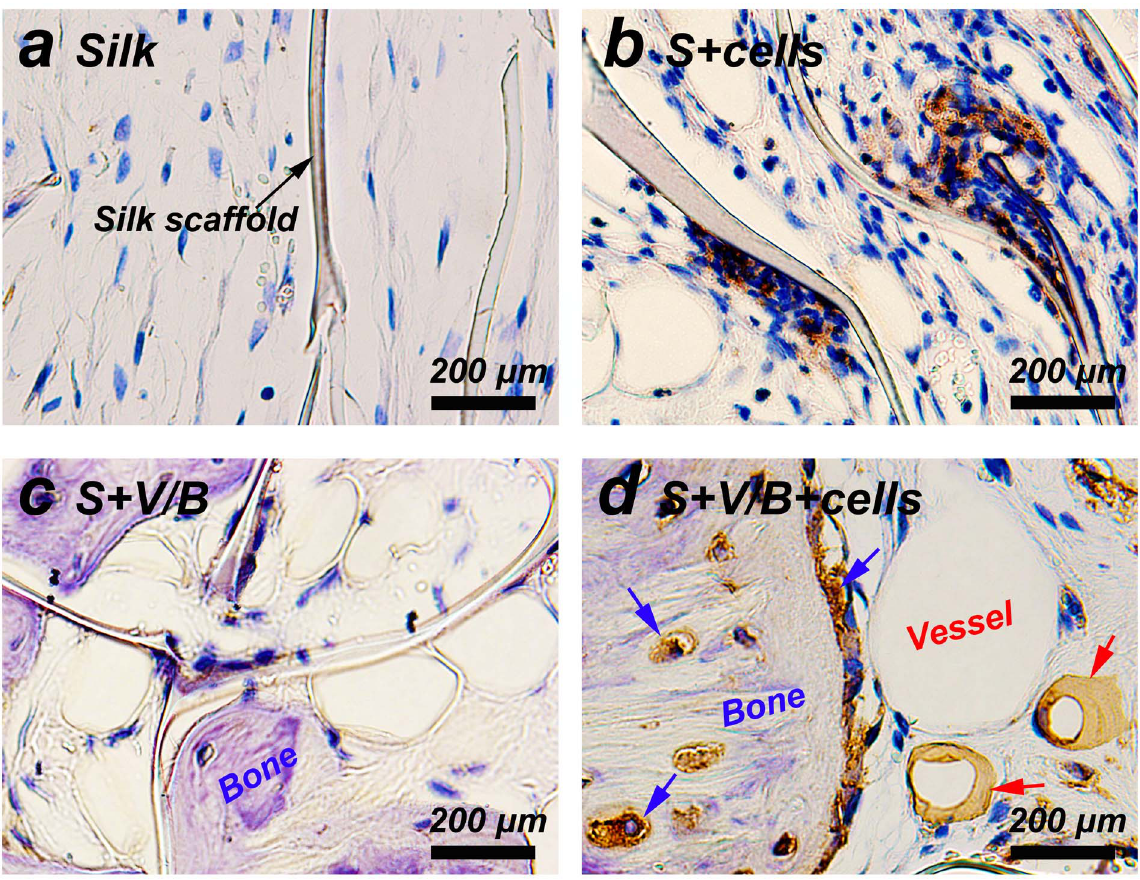
Figure 7. Immunostaining for GFP in each group at 8 weeks post-operation. GFP positive cells stained brownish yellow (b and d). Black arrow shows remnant of silk scaffold. Blue arrows indicate osteoblasts and osteocytes. Red arrows indicate endothelial